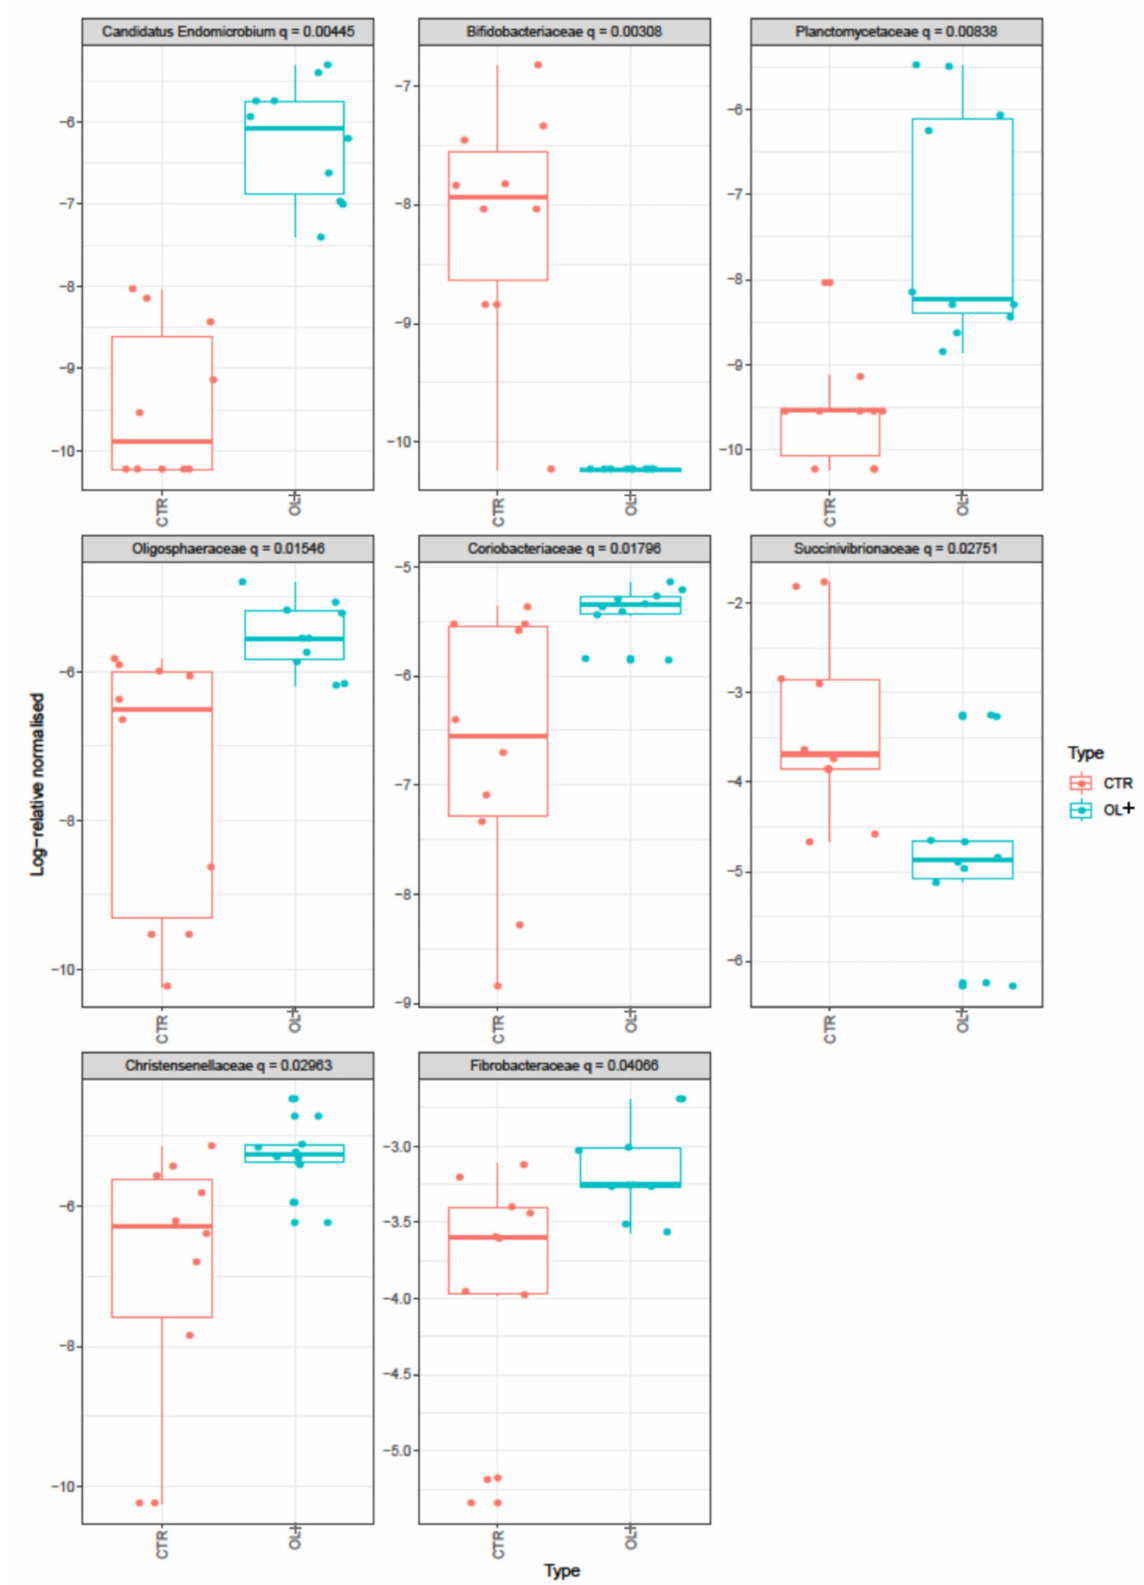
Figure 3. Boxplots showing the Bray-Curtis dissimilarities at family level. The boxes in the plot represent the interquartile ranges, the horizontal lines give the position of the medians, the vertical bars indicate the range. The dots indicate